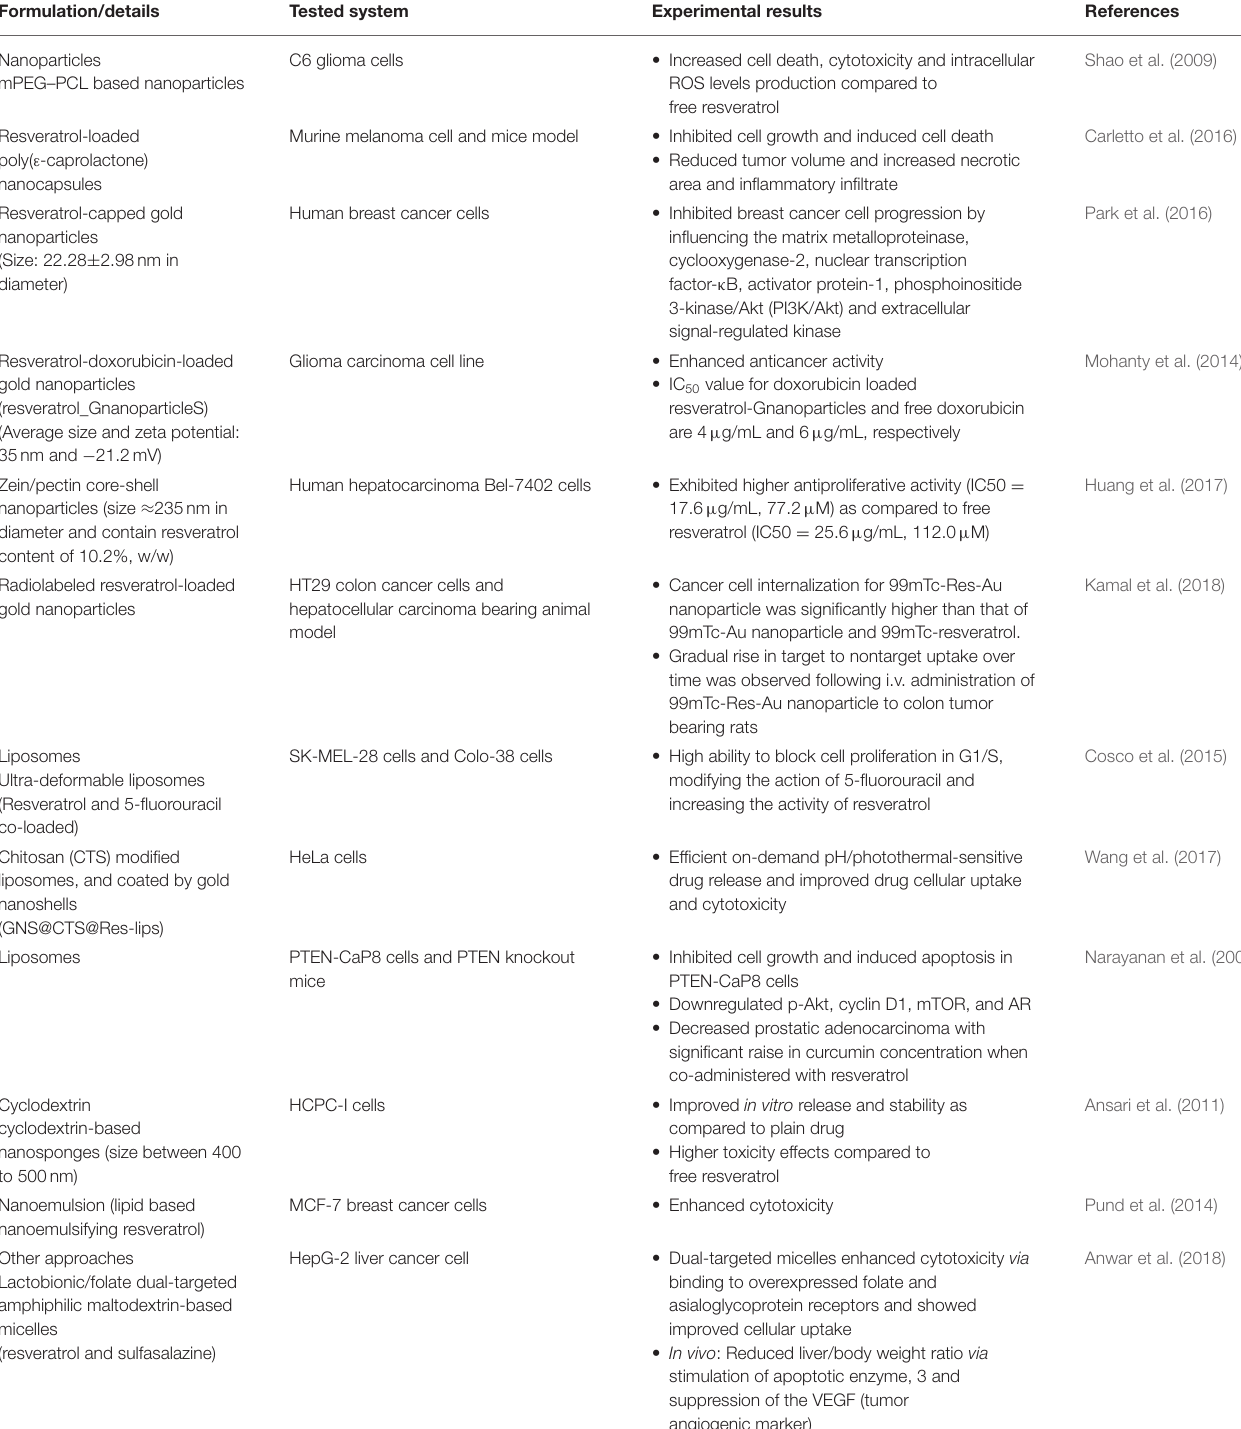
TABLE 1 | Nanoformulations of resveratrol for cancer